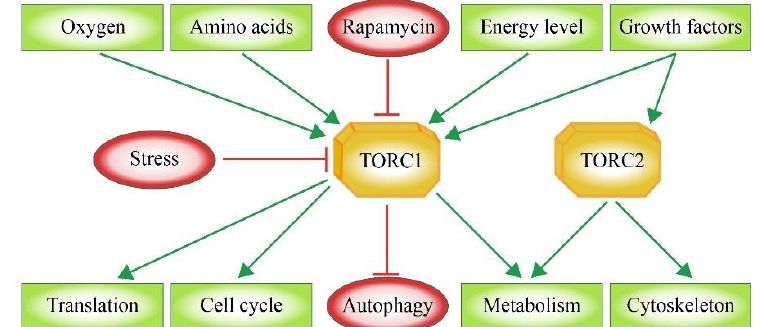
Figure 1. Cellular functions of TORC1 and TORC2. Growth factors activate both TORC1 and TORC2. Moreover, TORC1 integrates information concerning oxygen concentration, amino acid availability and changing energy levels, while it is inhibited by cellular stress and rapamycin. TORC1 supports translation, cell cycle, and cellular metabolism, while it inhibits autophagy. TORC2 controls cellular metabolism and cytoskeleton dynamics.